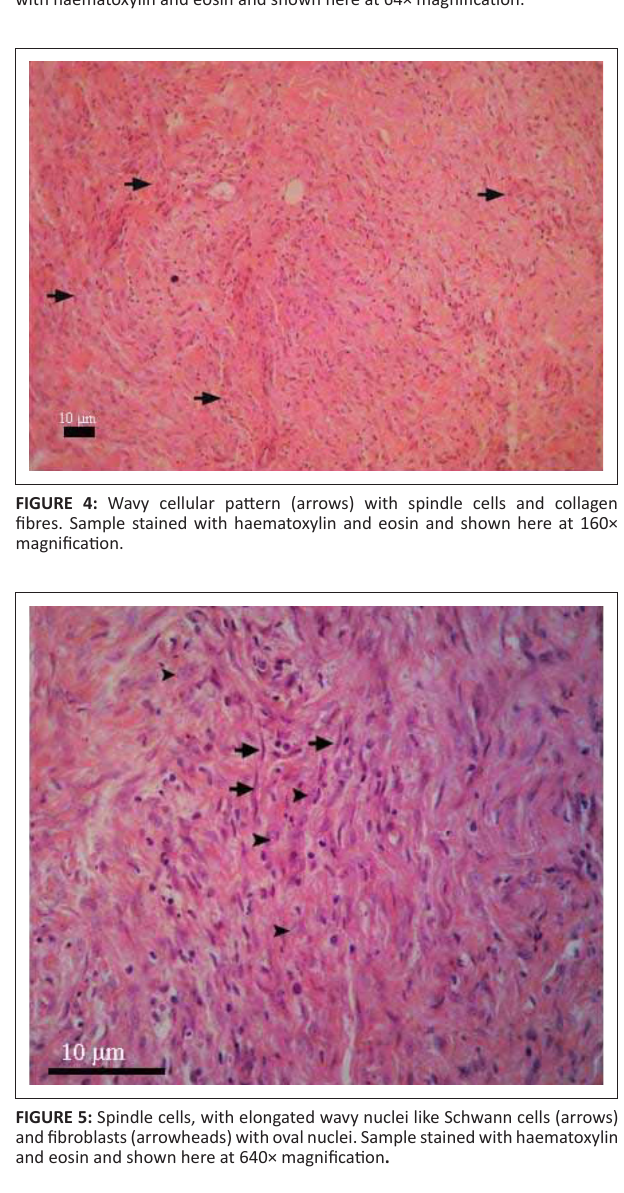
FIGURE 3: Tumour mass with a myelinated nerve fibre (arrowhead), multifocal lymphocytic infiltration (arrows) and fibromyomatous stroma. Sample stained with haematoxylin and eosin and shown here at 64× magnification.